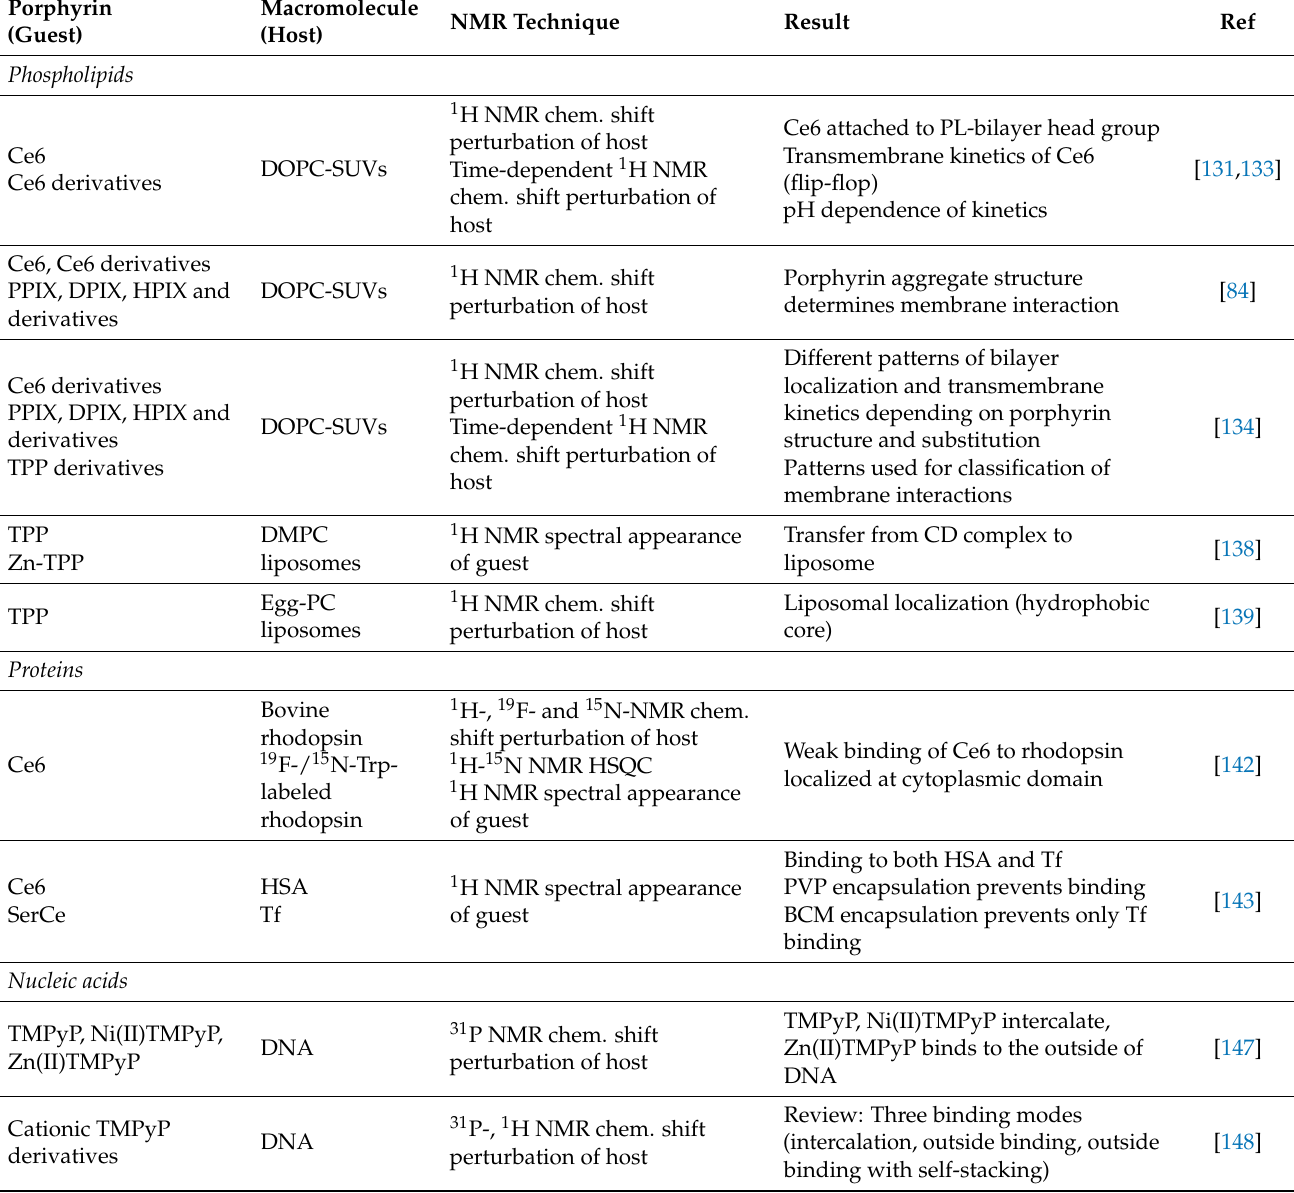
Table 1. Summary of NMR interaction studies between porphyrins and